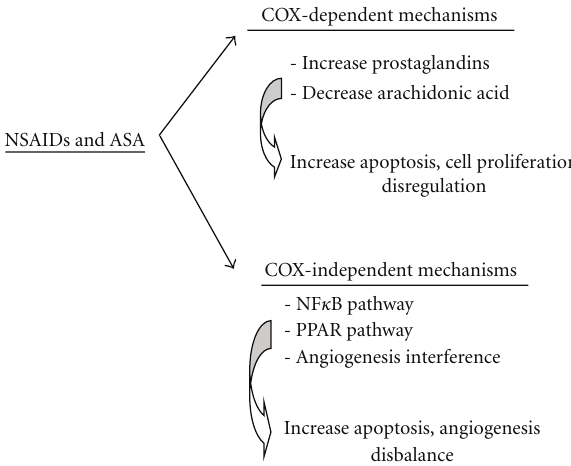
Figure 1: Scheme of COX-dependent and-independent mecha- nisms related with NSAID and